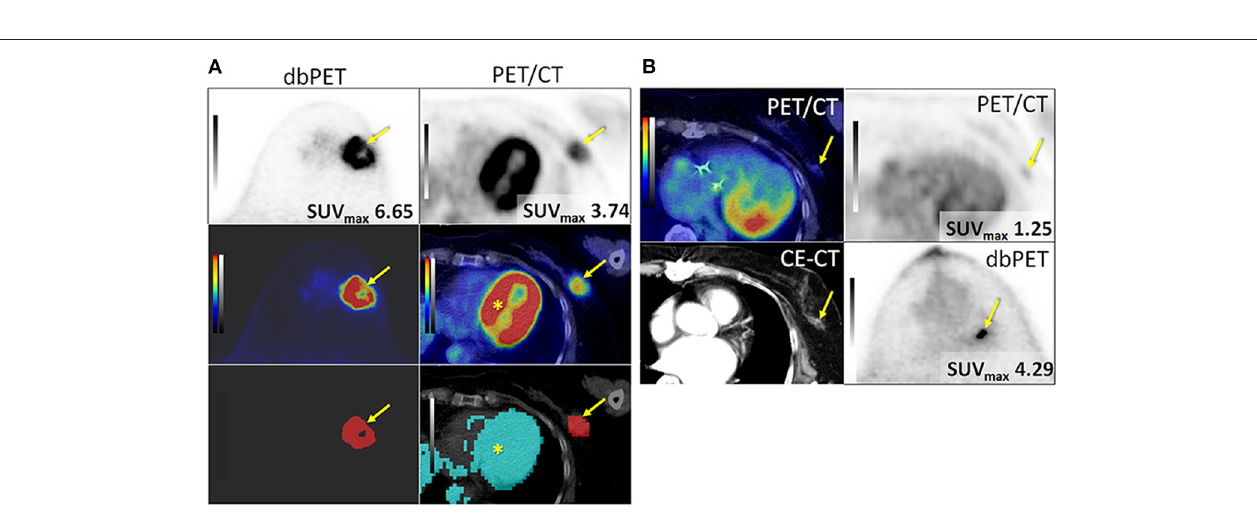
FIGURE 2 | Successfully (A) and unsuccessfully (B) extracted breast cancers with dbPET and whole-body PET/CT. (A) Invasive ductal carcinoma in the left breast of an 84-year-old woman. BC (arrow) was successfully extracted with both dbPET and whole-body PET/CT (two images at the bottom) and clearly separated from the physiological uptake of the myocardium (*) with whole-body PET/CT. (B) Invasive ductal carcinoma in the left breast of a 74-year-old woman. It was successfully extracted with dbPET but failed with whole-body PET/CT; therefore, it was excluded from this study. BC, breast cancer; CE-CT, contrast-enhanced computed tomography; dbPET, dedicated breast positron emission